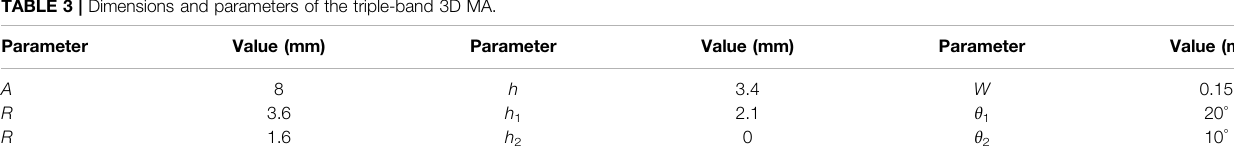
TABLE 3 | Dimensions and parameters of the triple-band 3D MA.